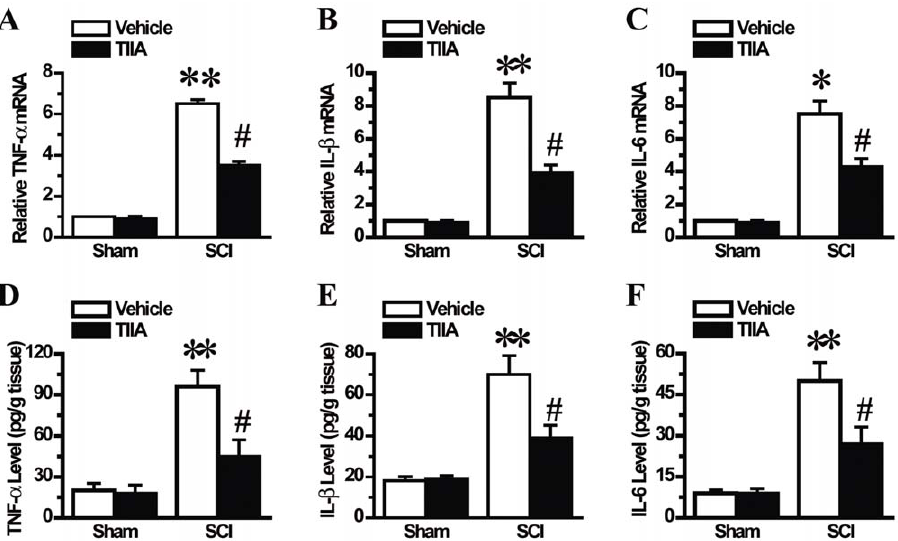
Figure 6. Effects of TIIA on the expression of pro-inflammatory cytokines at 6 h after SCI. The mRNA expression of TNF- a , IL-1 b and IL-6 was enhanced in the tissues from the SCI group, but treatment of TIIA reduced their mRNA expression (A–C). Compared to the sham and sham/TIIA groups, the protein level of TNF- a , IL-1 b and IL-6 was significantly up-regulated, whereas TIIA reduced the level of these proteins (D–F). Bars represent means 6 SEM. * p , 0.05, ** p , 0.001 vs. sham group; # p , 0.05 vs. SCI group.